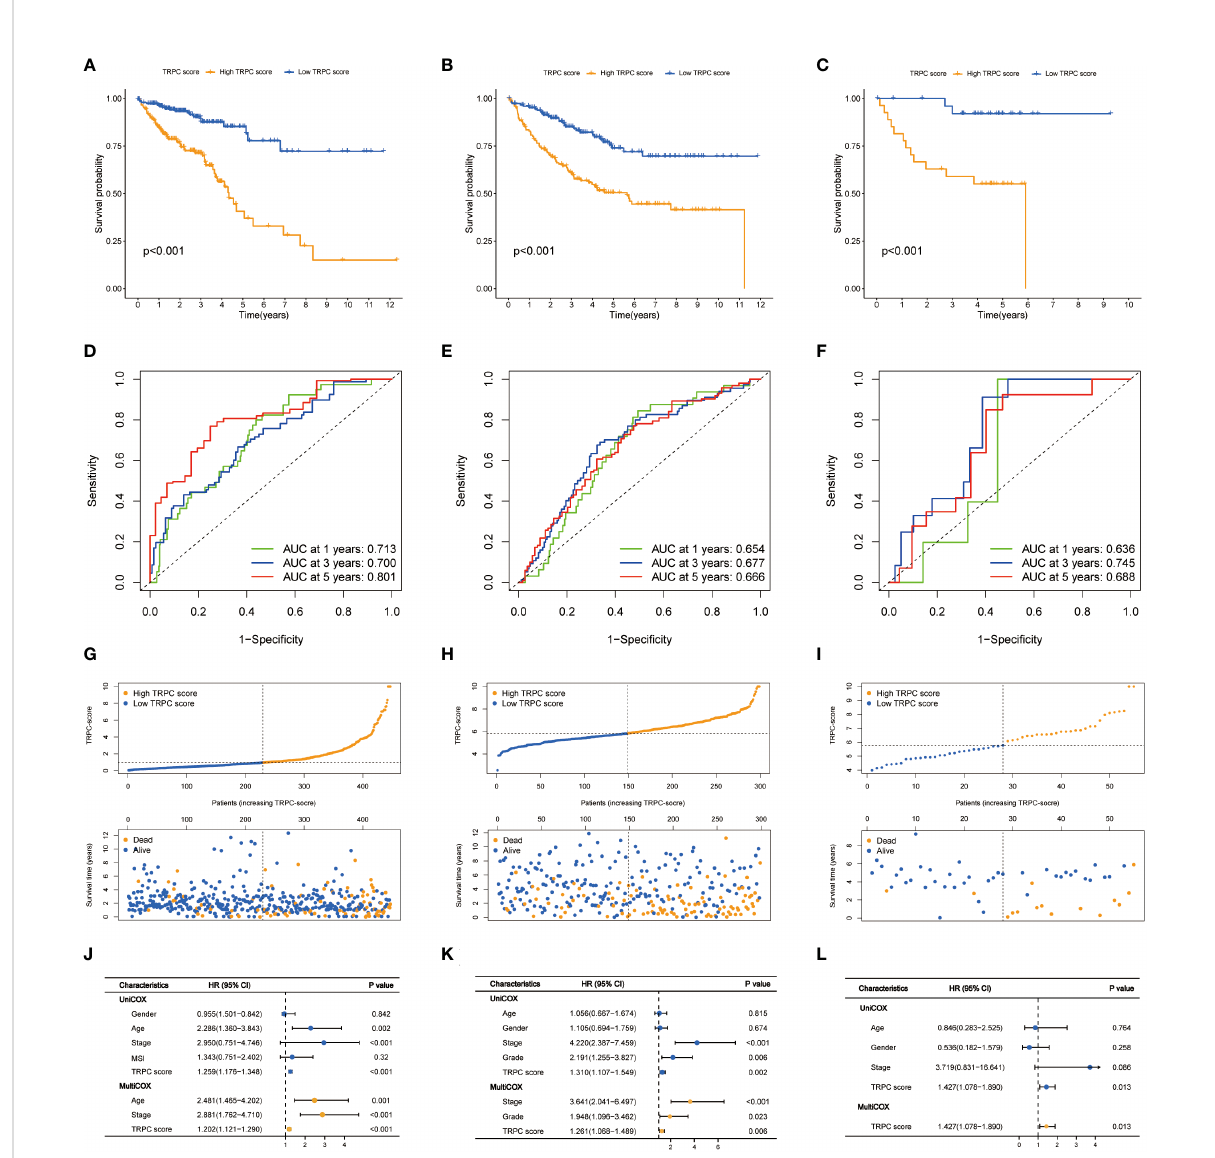
FIGURE 4 Prognostic analysis of TRPC scores. Kaplan – Meier curves (A-C) , time-dependent ROC curves (D-F) , risk plot distribution and survival status (G-I) , univariate and multivariate Cox regression analysis (J-L) of the TCGA cohort, the meta-GEO cohort, and the GSE17537 cohort. ROC, receiver operator characteristic; TRPC, transient receptor potential